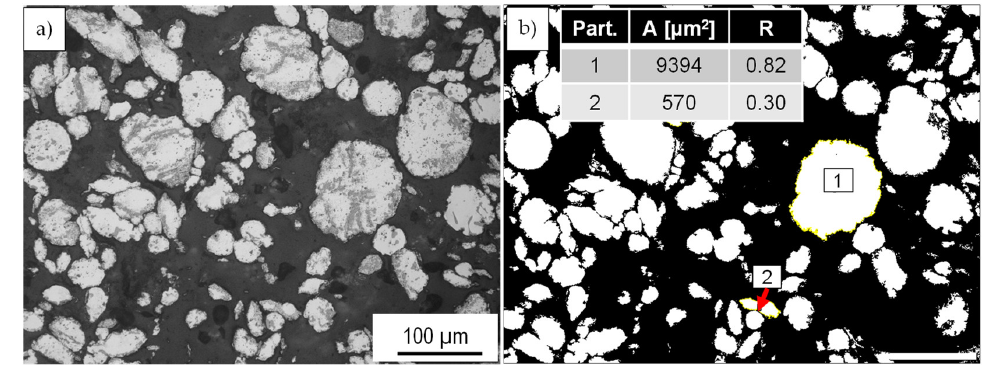
Figure 4. Analysis of the particle shape and particle area: ( a ) original light microscopic cross-section image and ( b ) processed picture with the image processing software ImageJ.